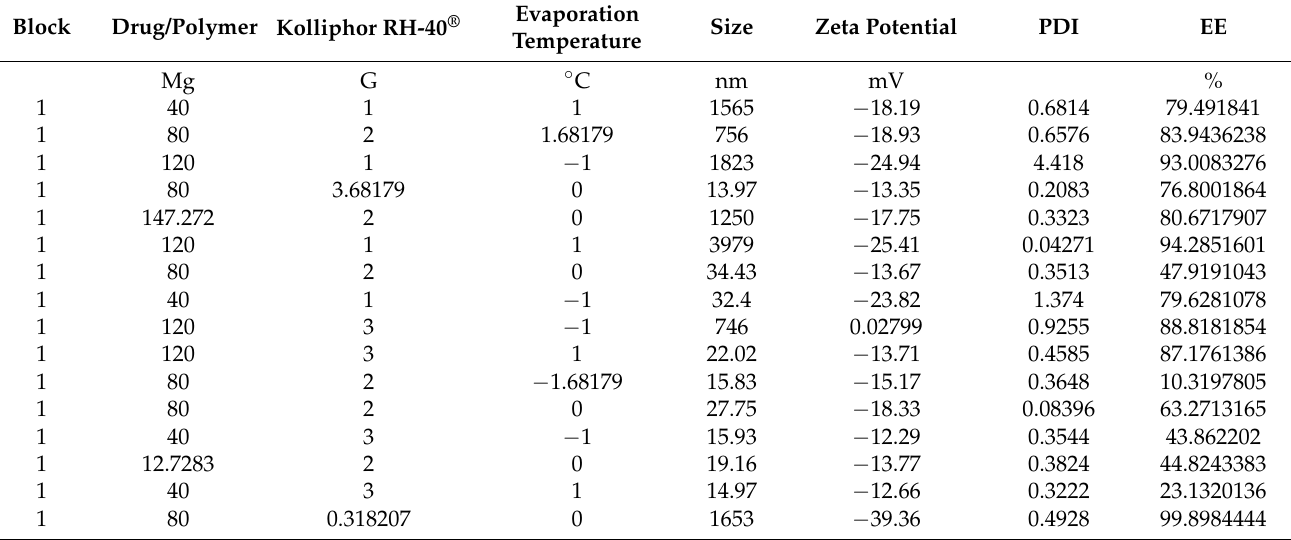
Table 7. Factors and responses established for optimization design.